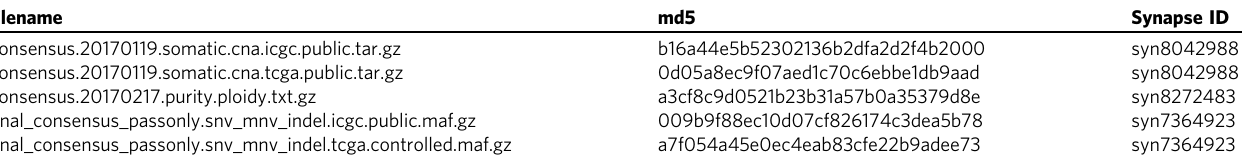
Table 1 PCAWG fi les downloaded from the ICGC data